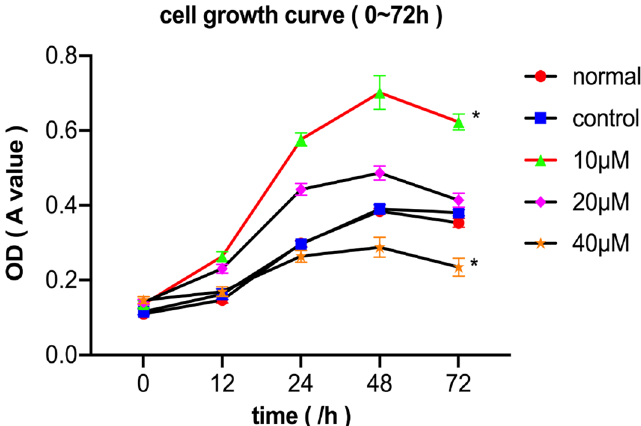
Figure 7. The cell growth curve showed that the 10 μM quercetin group had a proliferative effect on T lymphocytes of OLP patients (the none-erosive and erosive OLP patients, n = 20), while the 40 μM quercetin group showed an inhibitory effect (* p < 0.05 versus the control group). The normal group represented T lymphocytes of healthy controls without any